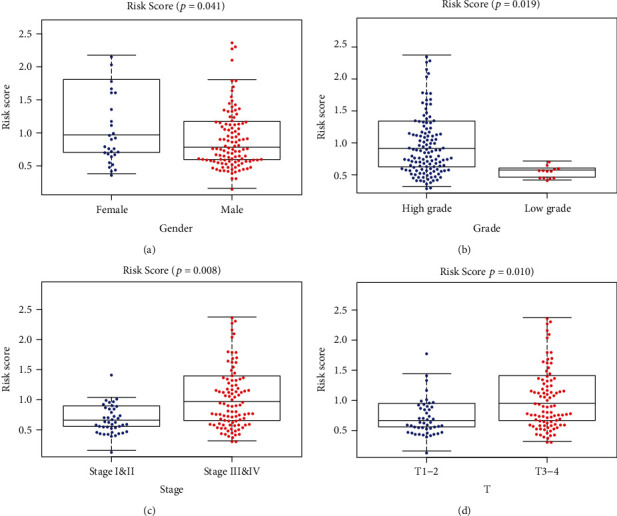
The scatter plot of the relationship between the signature and (a) gender, (b) grade, (c) staging, and (d) T stage.